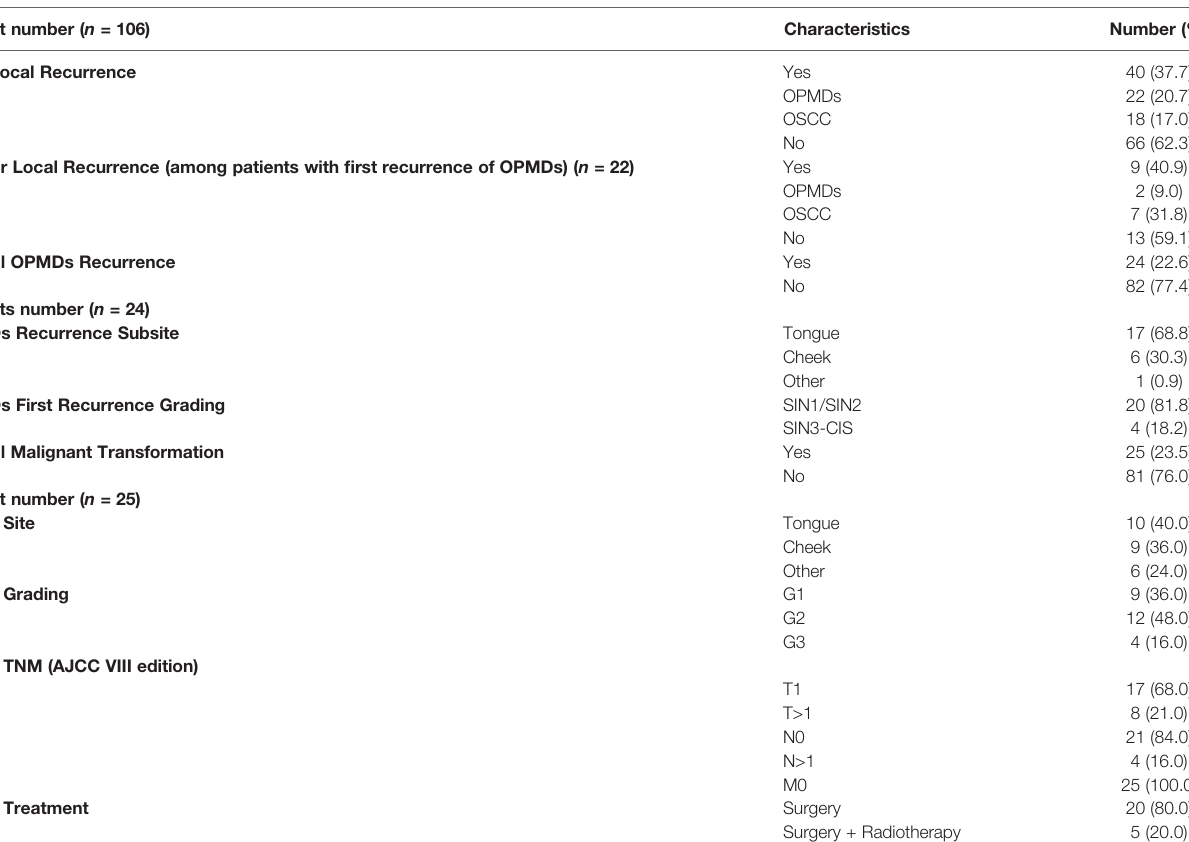
TABLE 2 | Descriptive analysis of clinical evolution of